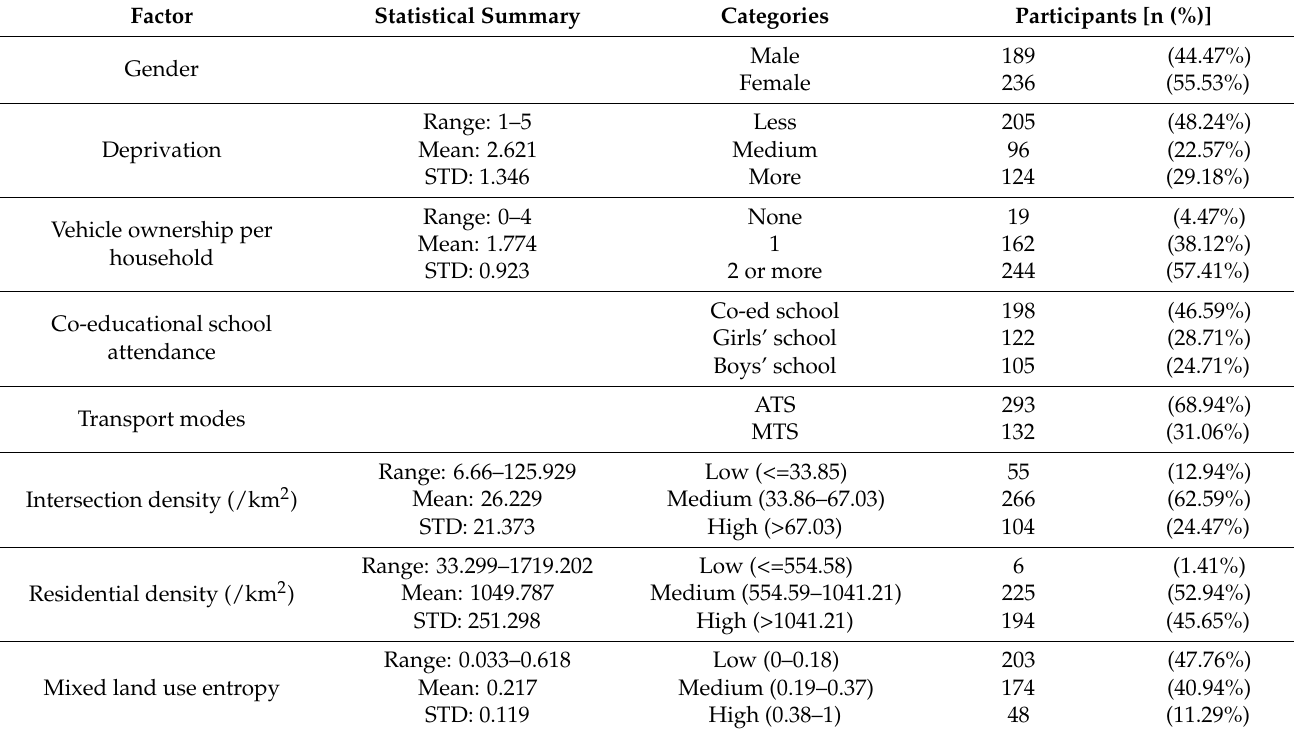
Table 1. Classes of ATS